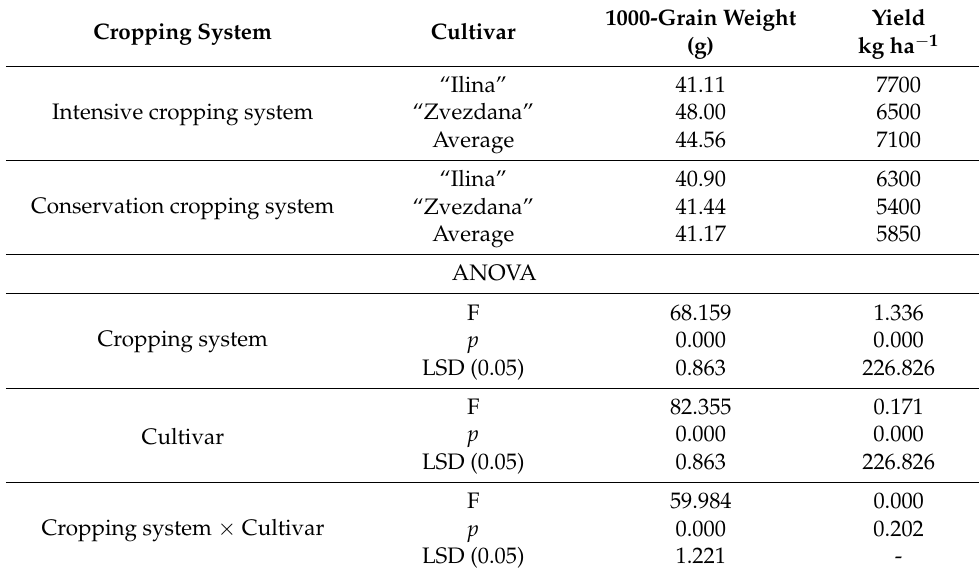
Table 6. Yield (kg ha − 1 ) and 1000-grain weight (g) of the examined wheat cultivars in different cropping